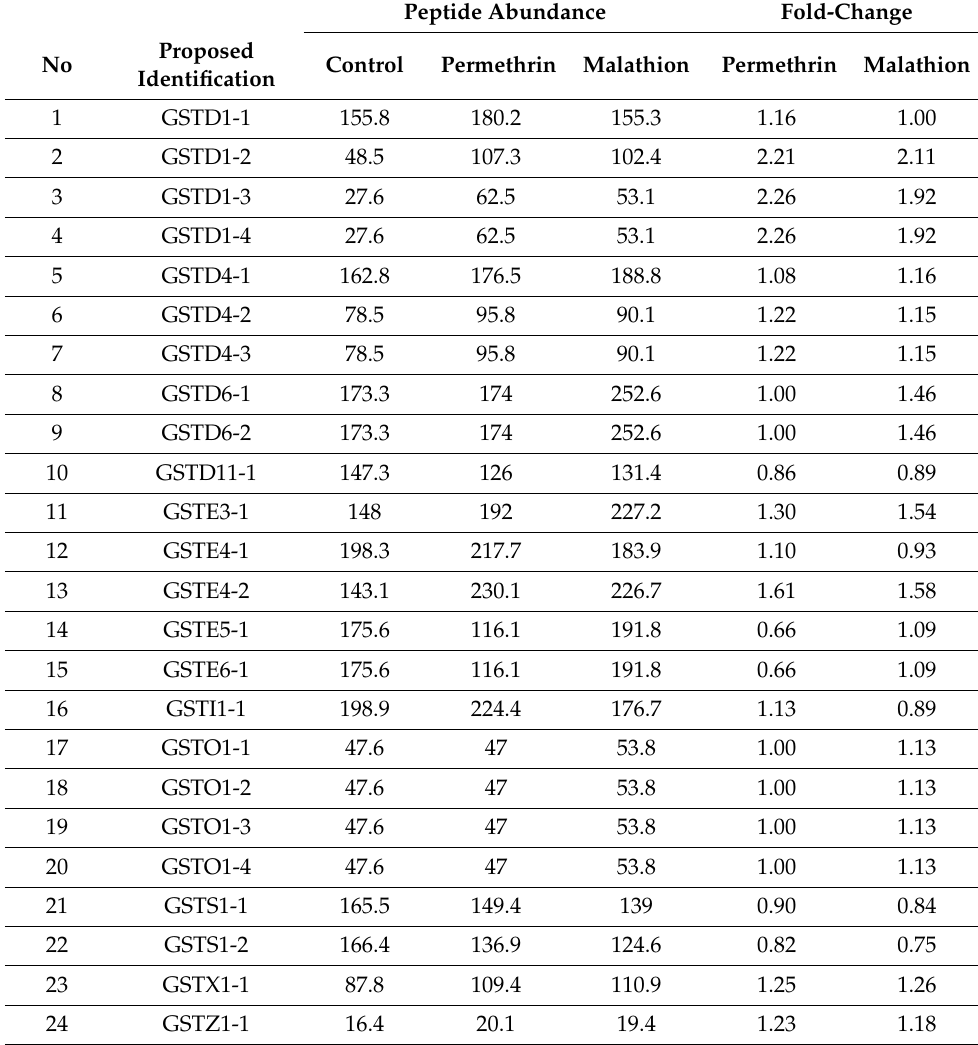
Table 7. Peptide abundance response of glutathione s-transferase isoforms in Aedes albopictus larvae upon 24 h of acute permethrin and malathion treatments. Peptide Abundance Fold-Change Proposed Control Permethrin Malathion Permethrin No Identification